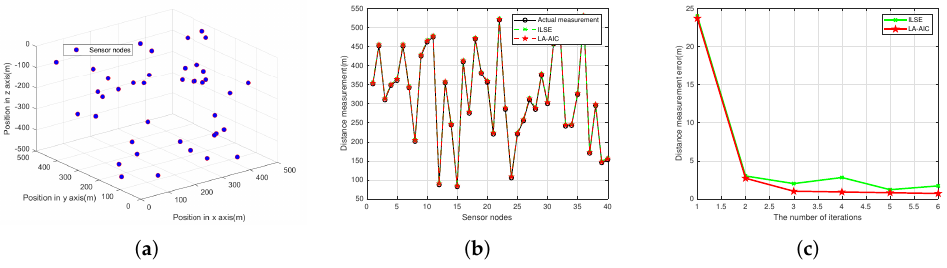
Figure 11. Simulation of LA-AIC (first scenario). ( a ) The distribution position of sensor nodes. ( b ) Real distance and measured distance. ( c ) Ranging error.